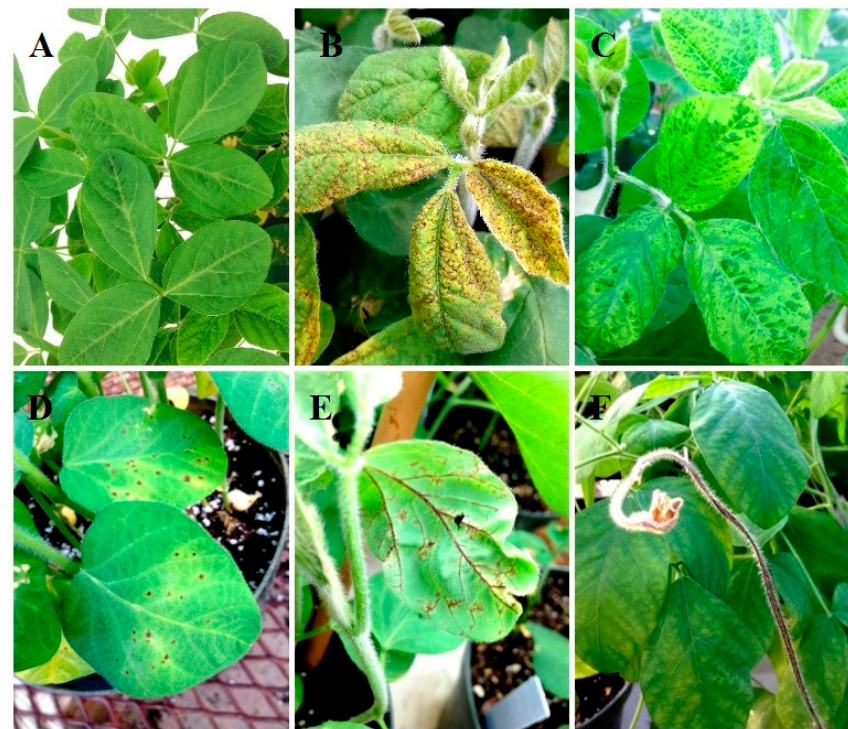
Figure 1. Symptoms of soybean genotypes infected with Soybean mosaic virus : ( A ), resistant genotype showing no symptoms of the disease; ( B ), necrotic genotype showing stem-tip necrosis; ( C ), susceptible genotype displaying mosaic symptoms; ( D ), local necrosis restricted to the infection site; ( E ), systemic necrosis with browning of leaf veins; ( F ), stem-tip necrosis with browning of the stem. Resistant soybeans have no disease symptoms and are undistinguishable from non- infected plants. A host plant is resistant if it can block viral replication and movement (cell-to-cell or long-distance) and, therefore, cannot be detected visually or by using the enzyme-linked immunosorbent assay (ELISA) test [92]. A resistant reaction restricts the virus to the infection site and prevents disease dispersion. In a resistant reaction, the pathogen is described as avirulent, and the virus–host interaction is incompatible